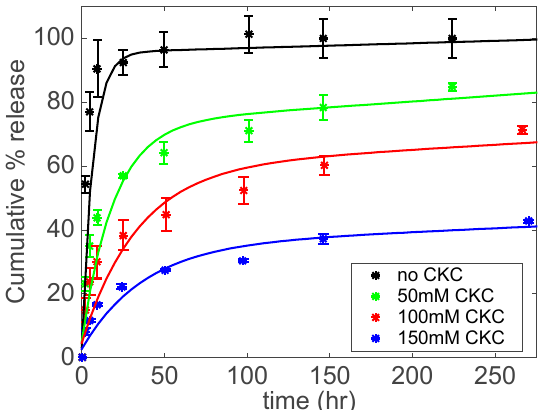
Figure 6. FBNa cumulative % release as a function of time under different CKC concentrations. Catanionic aggregates were prepared at a fixed concentration of FBNa (20 mM) and Brij 97 (20 wt%). Total amount of drug per lens: 77.3 ± 6.1 µg for No CKC; 88.1 ± 3.2 µg for 50 mM CKC; 69.3 ± 8.7 µg for 100 mM CKC; 83.7 ± 2.8 µg for 150 mM CKC. Data are presented as mean ± standard deviation with n = 3.